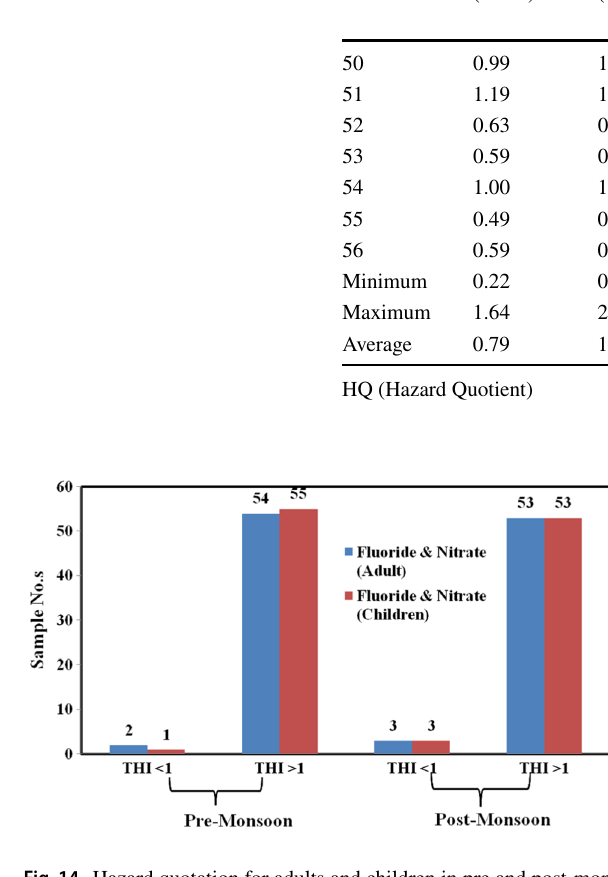
Fig. 14 Hazard quotation for adults and children in pre and